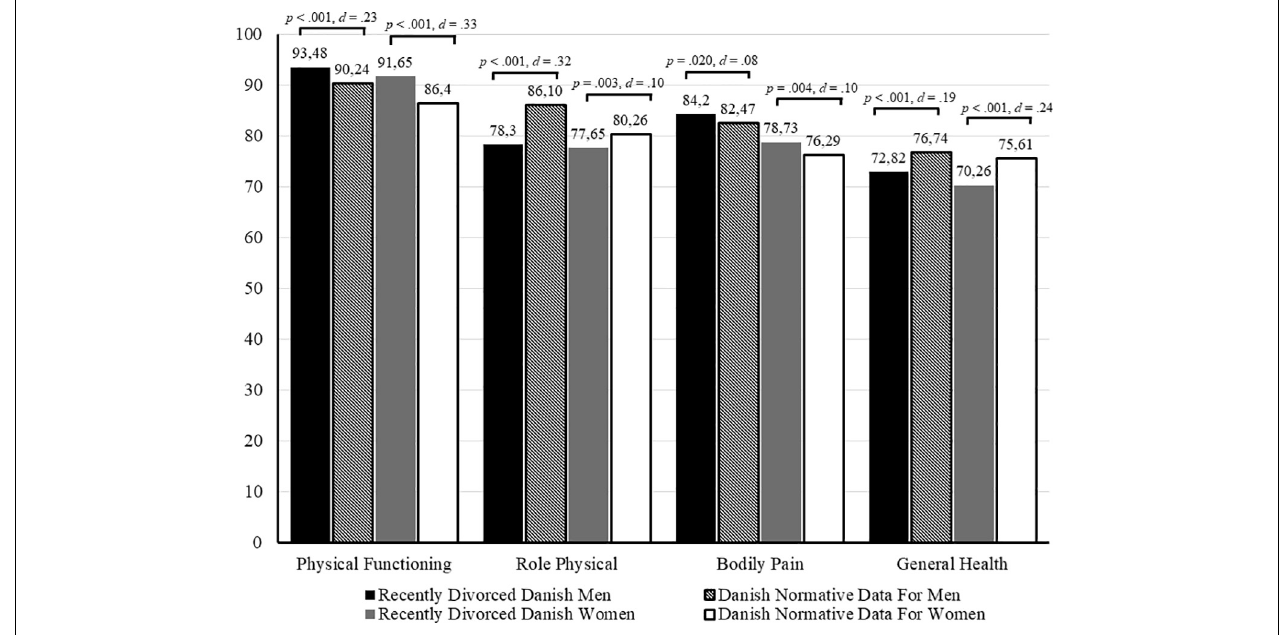
FIGURE 1 | SF-36 physical health domain means compared to normative